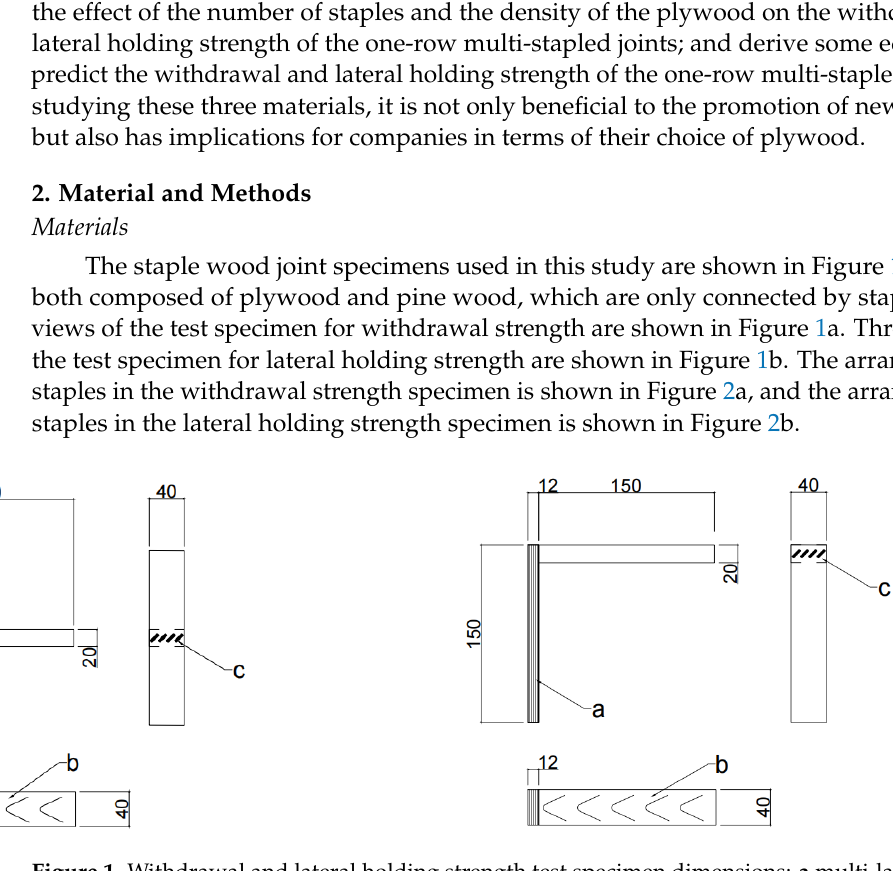
Figure 1. Withdrawal and lateral holding strength test specimen dimensions: a multi-layer board, b pine chord-cut board, c staple.